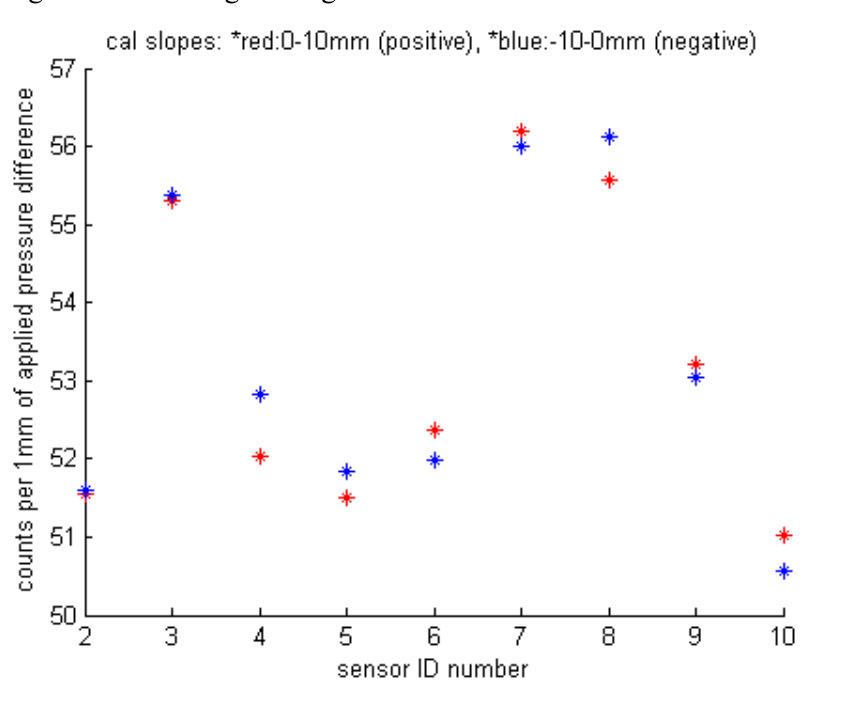
Figure 7. Sensitivity (slope) of each of 9 DP loggers. These data include any effects of variance in signal conditioning and